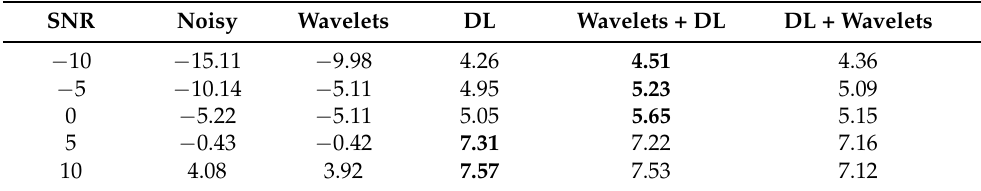
Table 4. Pink noise SegSNR. The higher values represent better results. In bold is the best result for each SNR